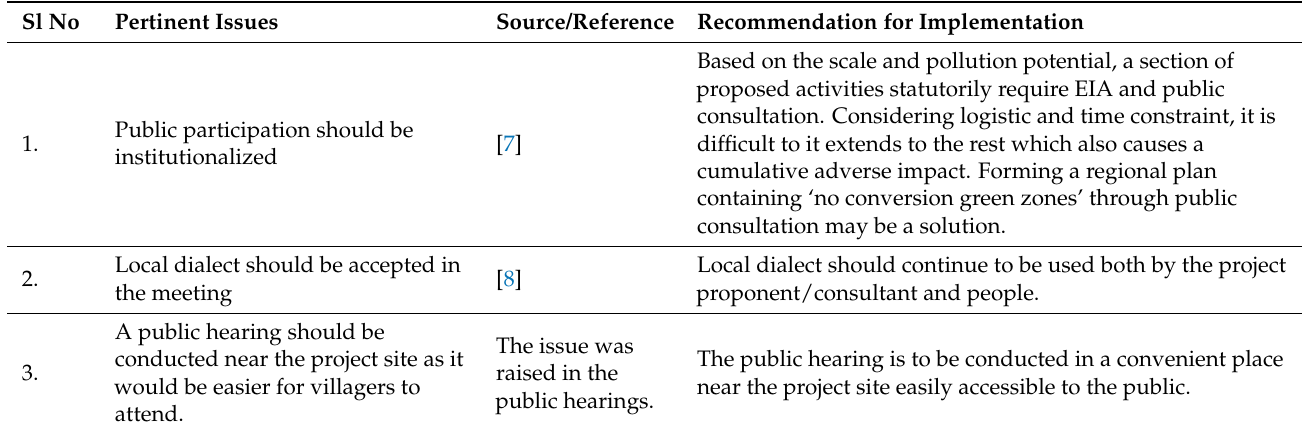
Table 2. Recommendations to provide opportunity and conducive environment for public participation in